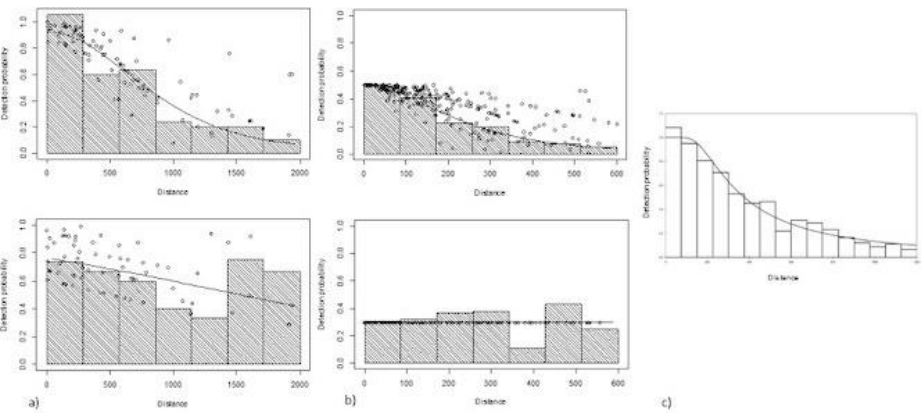
Figure 9. 2002 – 2007 survey detection function curves for pooled detections (top) and the conditional detection probabilities of platform 1 (bottom) for (a) killer whales (a); harbour porpoises (b); and the detection function curve of the platform 1 detection distances for Lagenorhynchus spp.